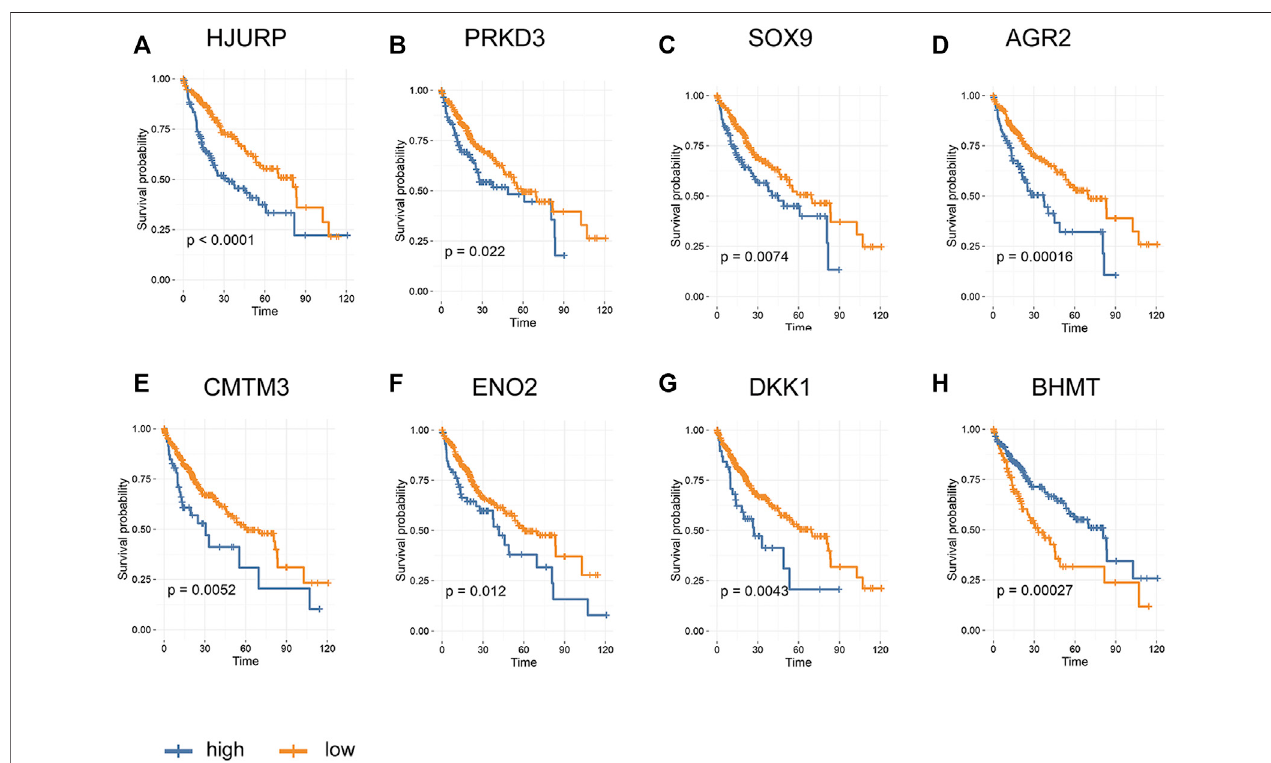
FIGURE5| Kaplan-MeiersurvivalanalysisbasedonproteinsexpressioninHCC (A) HJURP; (B) PRKD3 (C) SOX9; (D) AGR2 (E) CMTM3; (F) ENO2 (G) DKK1; (H) BHMT.